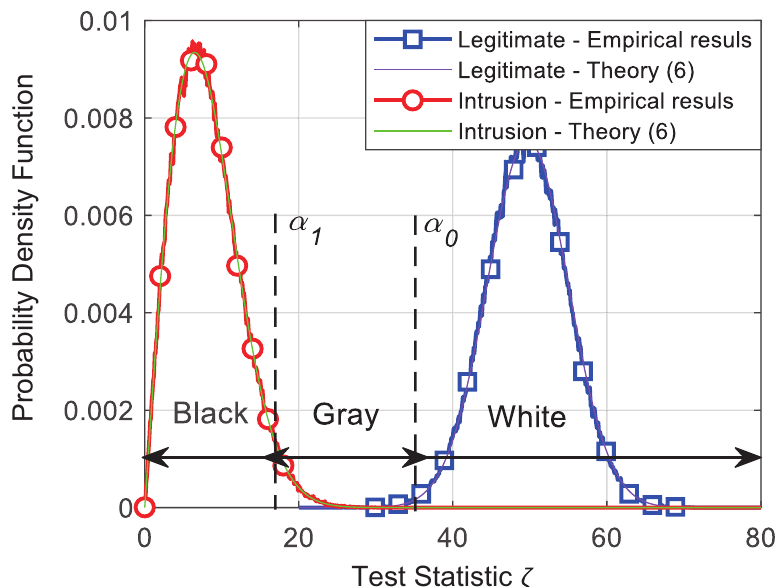
Figure 2. Comparison of the probability density functions.